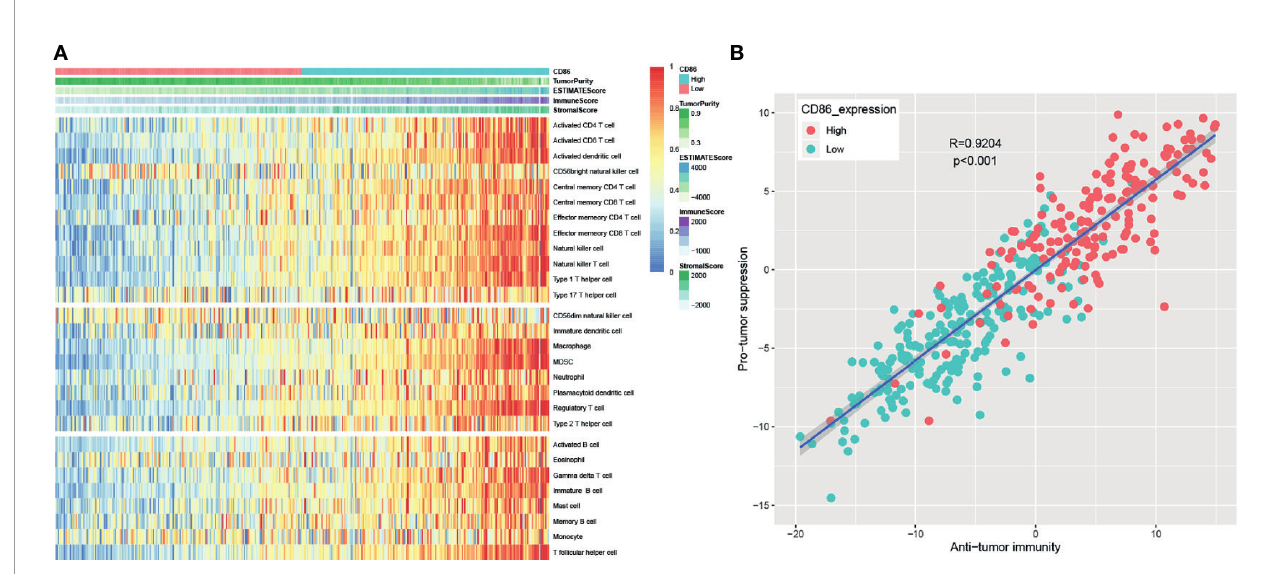
FIGURE 8 | Correlation between CD86 expression and immune cell in fi ltration heterogeneity. Differentially expressed genes (DEGs) analysis in ccRCC. (A) Single- sample gene set enrichment analysis identifying the relative in fi ltration of immune cell populations for 408 BC tumor samples with available RNA-sequencing data. The relative in fi ltration of each cell type is normalized into a z-score. (B) Correlation between in fi ltration of cell types executing anti-tumor immunity (ActCD4, ActCD8, TcmCD4, TcmCD8, TemCD4, TemCD8, Th1, Th17, ActDC, CD56briNK, NK, NKT) and cell types executing pro-tumor, immune suppressive functions (Treg, Th2, CD56dimNK, imDC, TAM, MDSC, neutrophil, and pDC). R coef fi cient of Pearson ’ s correlation.